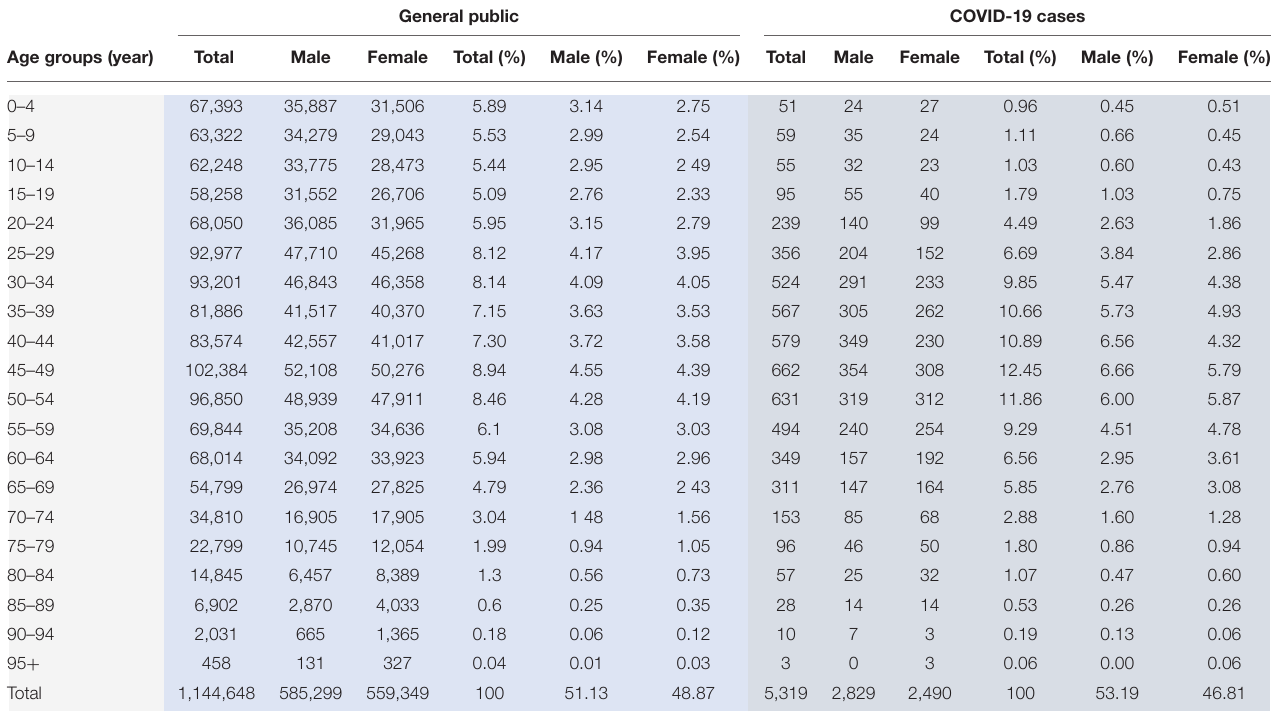
TABLE 1 | Age and gender composition of the general public and the identified COVID-19 cases. General